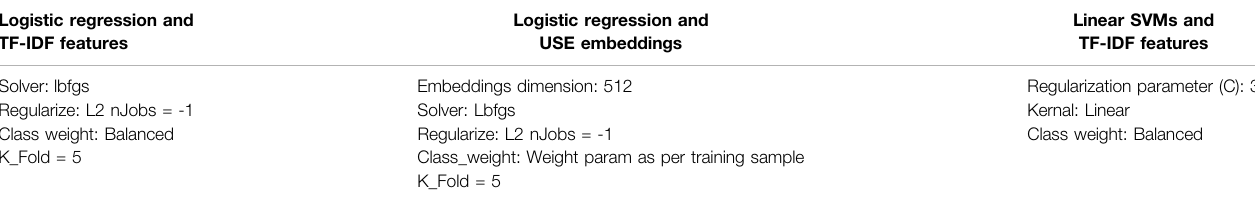
TABLE 2 | Hyperparameters used for training the classi fi ers. Logistic regression and TF-IDF features